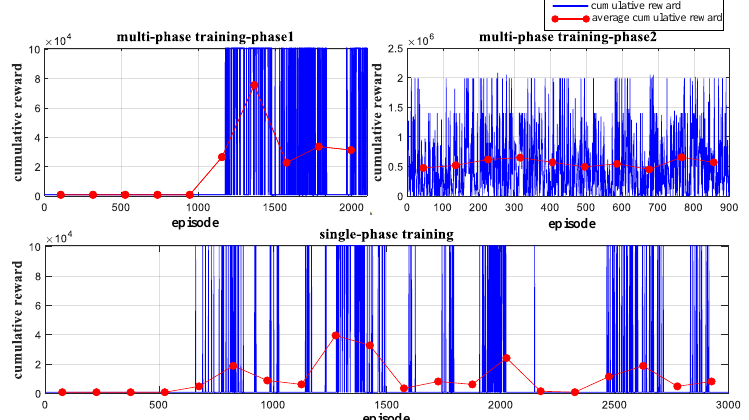
Figure 7. Comparative cumulative rewards of single- and multi-phase